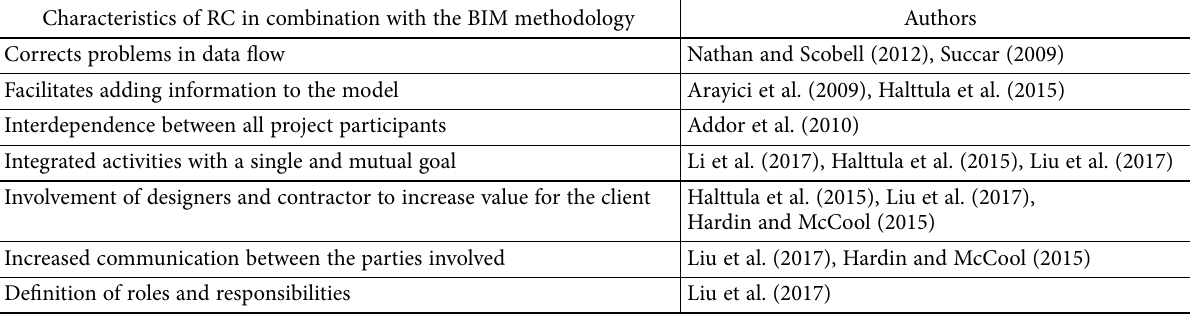
Table 2. Main characteristics of RC in combination with the BIM methodology in reducing AI Characteristics of RC in combination with the BIM